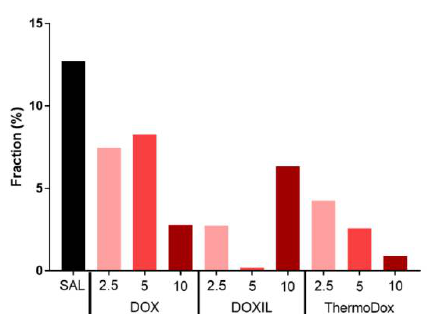
Figure 5 . Dividing cell fraction over the whole tumor. The dividing cell fraction was calculated after tumors treated with SAL, DOX, DOXIL, and ThermoDox at doses of 2.5, 5, and 10 mg/kg. The tumor treated with DOXIL at a dose of 10 mg/kg was unexpectedly high.